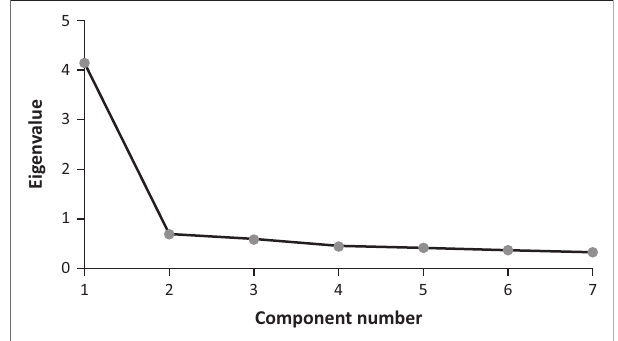
FIGURE 1: Cattell’s scree TABLE 3: Results of the Monte Carlo parallel analysis. Component number